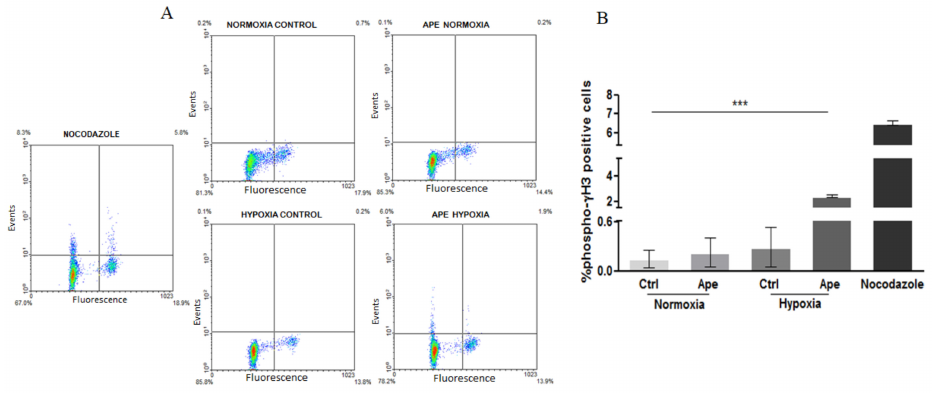
Figure 5. ( A ) (FACS) analysis of the cell positive for p-H3 in normoxia and hypoxia and in presence or absence of 100 µ M Ape (24 h). Nocodazole (0.2 µ g / mL) was used as positive control. ( B ) Percentage of phospho-Histone H3 positive cells in di ff erent experimental conditions. The data are the mean ± SEM of the three independent experiments ( t -test analysis *** p < 0.001; Ape hypoxia vs all experimental conditions).